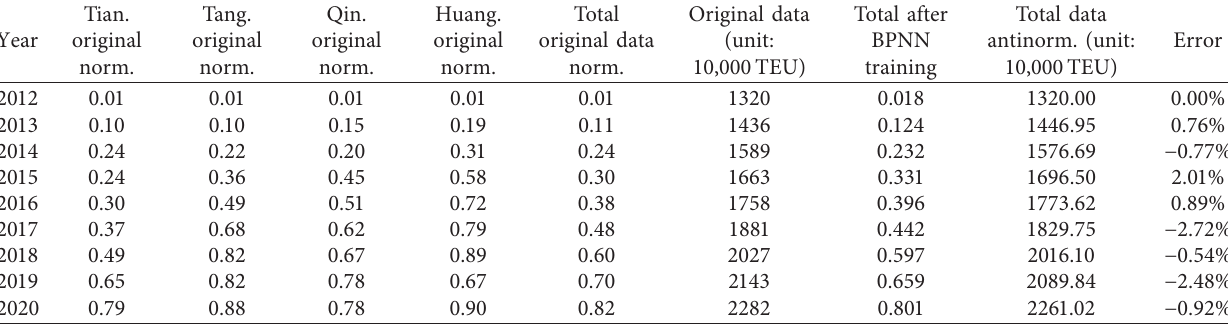
Table 5: Comparison of BP neural network and the original data.